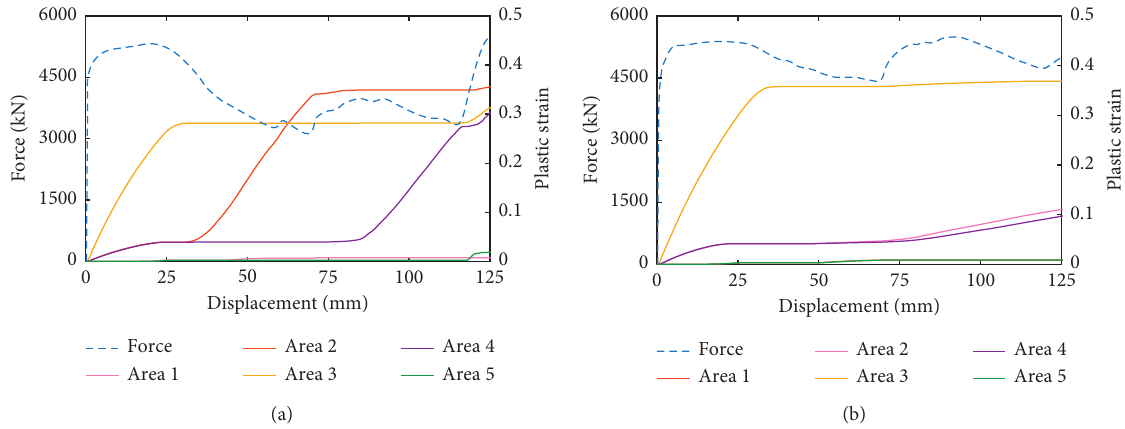
Figure 13: Displacement curve of load and plastic strain of each analysis area on the convex side of device (a) before thickened and (b) after thickened.